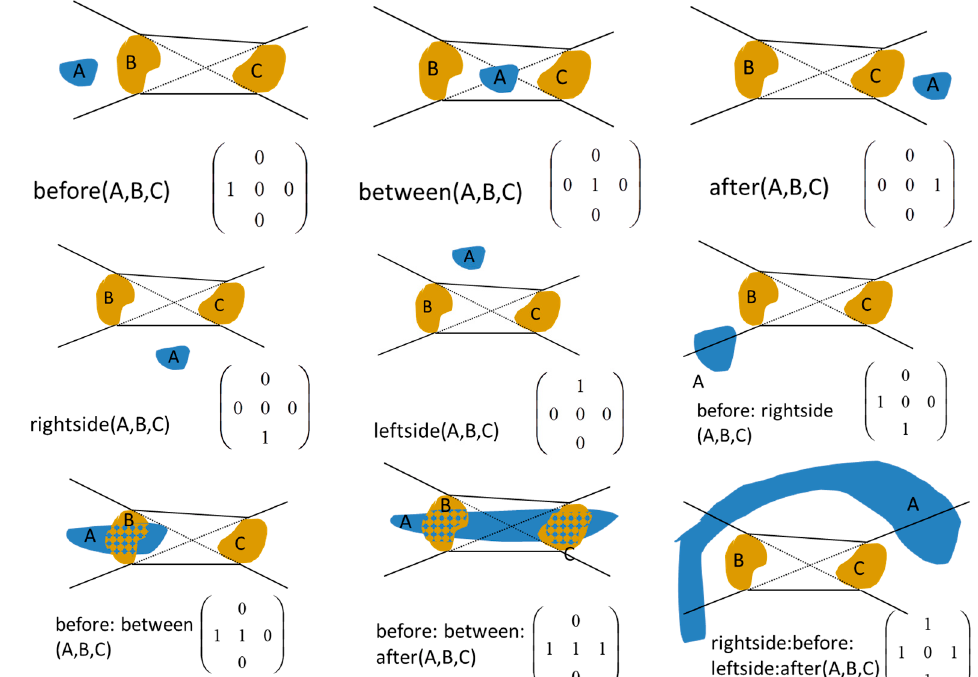
Figure 1. The partition of the plane into five areas by reference regions B and C (figure taken from [25]).